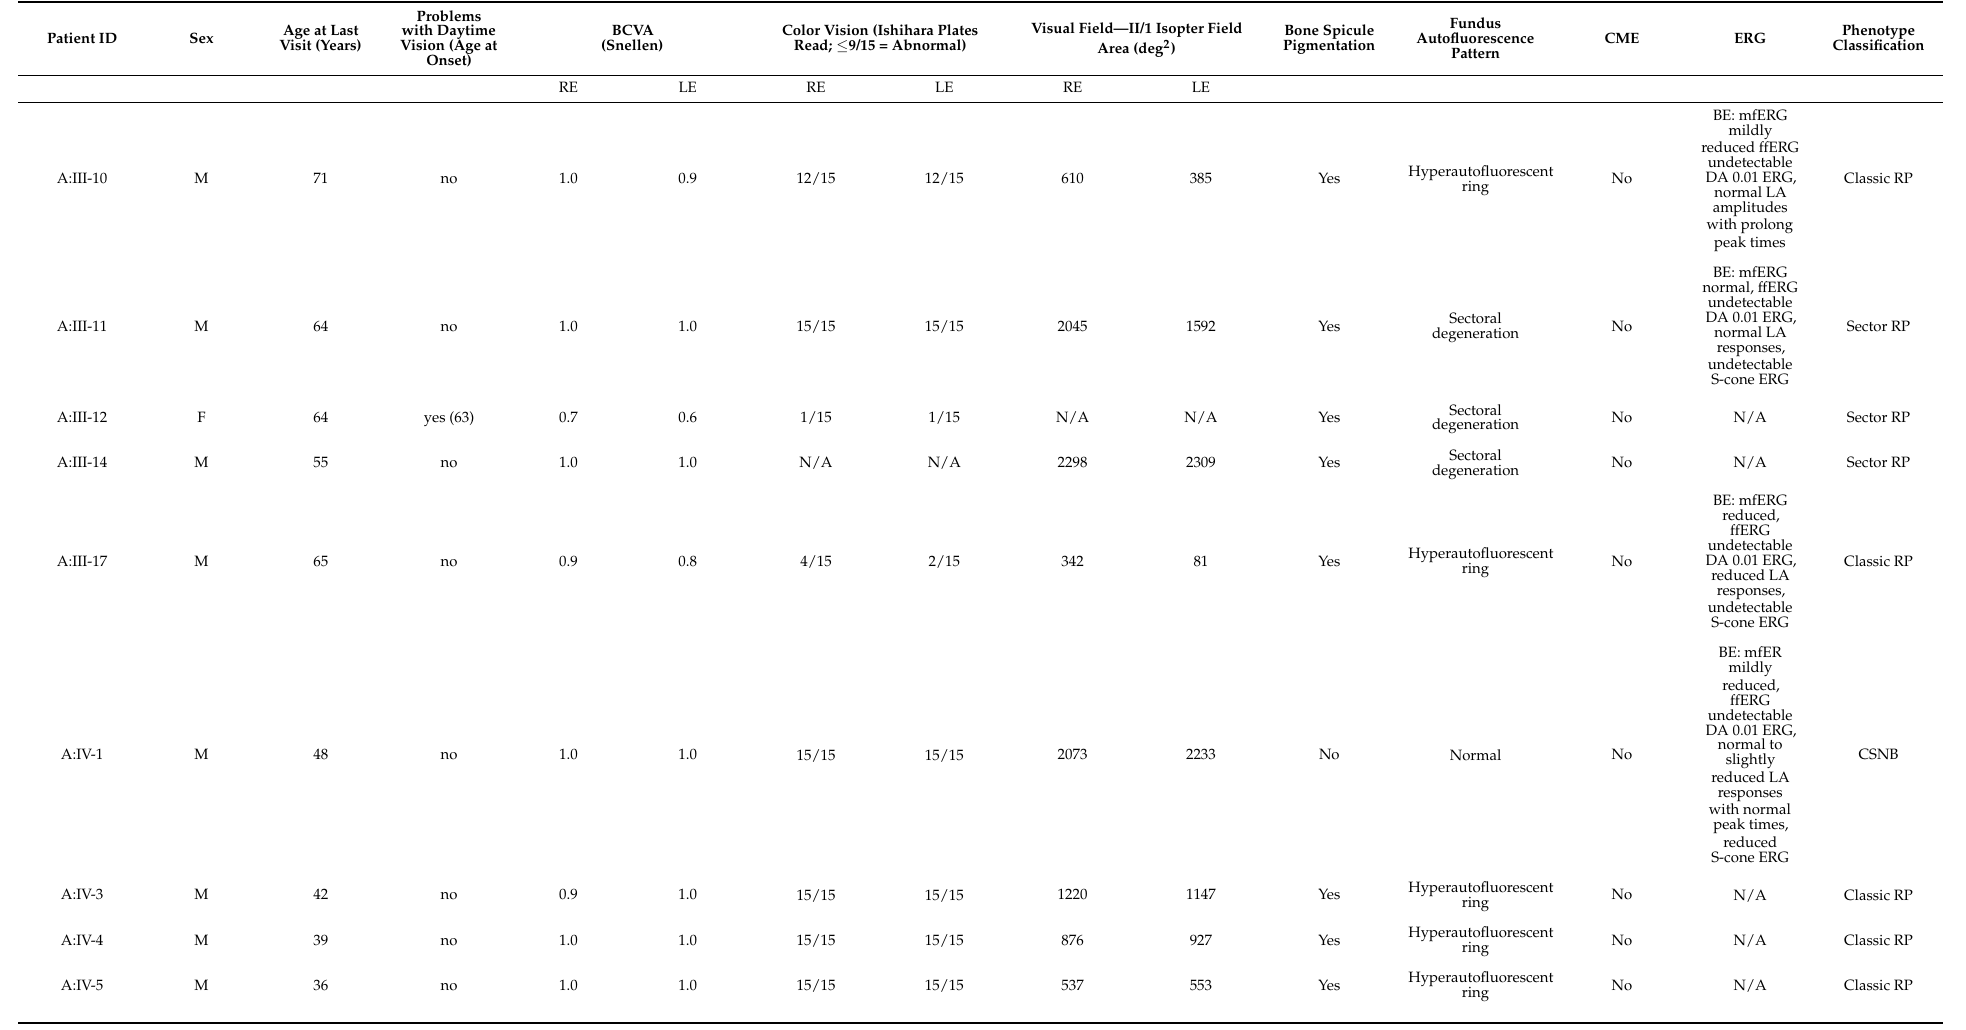
Table 1. Results of ophthalmological examination, electroretinography and phenotype